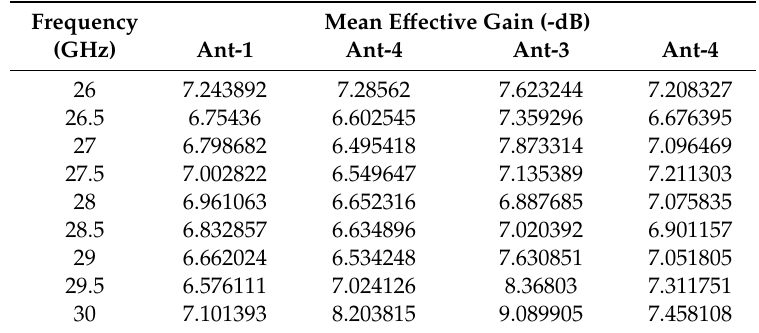
Table 3. The mean e ff ective gain of the reported Table 3. The mean effective gain of the reported antenna.